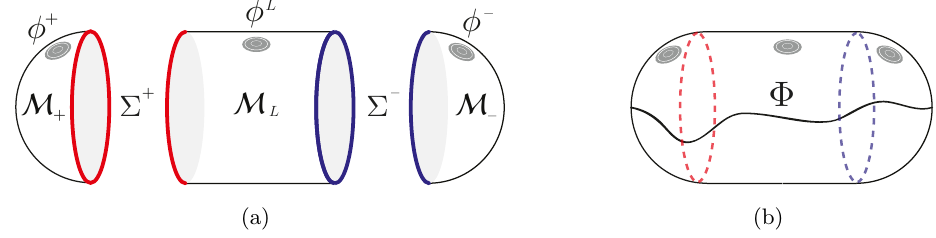
Figure 1 . Bulk dual to the In-Out formalism as a gluing of Lorentzian and Euclidean AdS